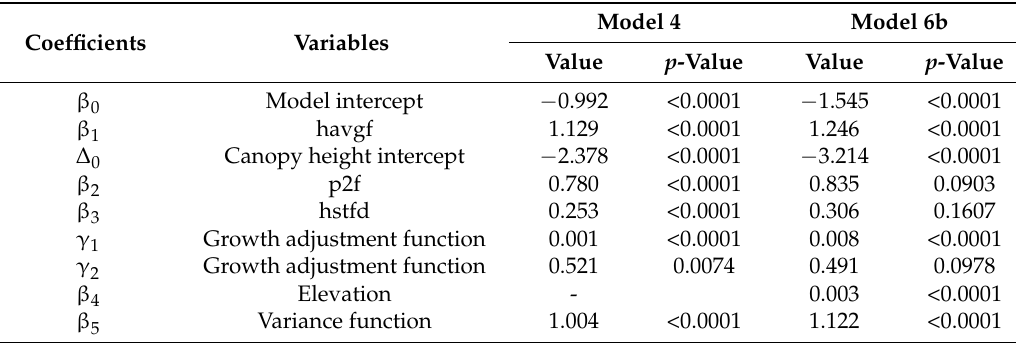
Table 5. Fixed coefficients of candidate merchantable volume models.